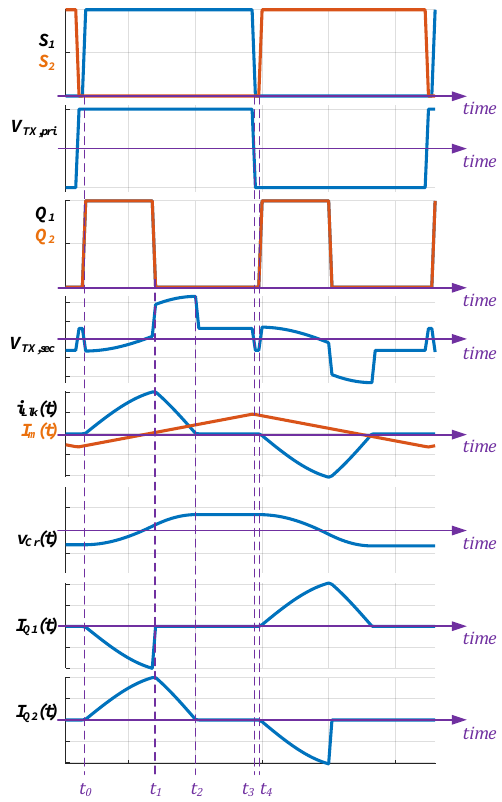
Figure 6. Idealized steady-state waveform with the proposed short-pulse PWM scheme for ∆𝑉 𝐶𝑟 > 2𝑛𝑉 𝐼𝑁 .